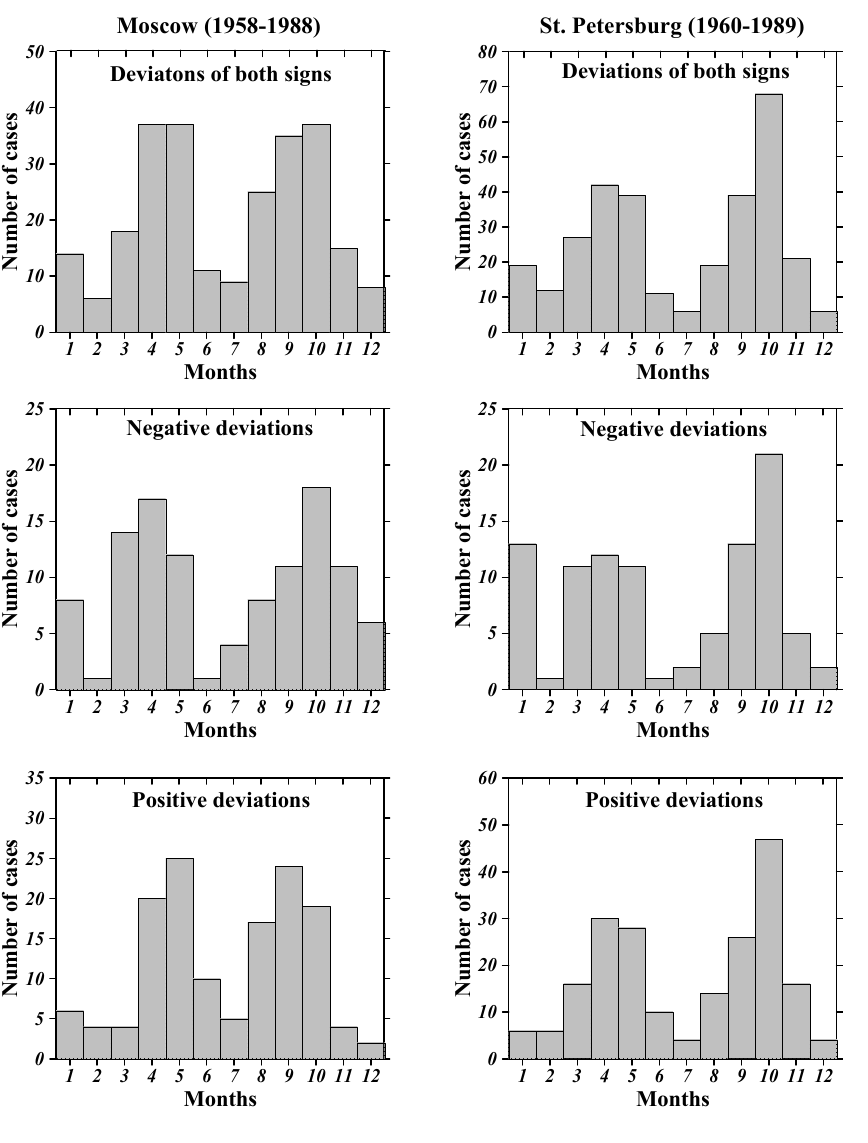
Fig. 4. Annual distribution of strong quiet-time ( Ap ≤ 12) deviations at Moscow and St. Petersburg for a 30- year period. Histograms for positive, negative deviations as well as for their sum are given separately.“Strong” was defined as a NmF2 deviation > 40% from monthly median. Note the annual peaks clustering around